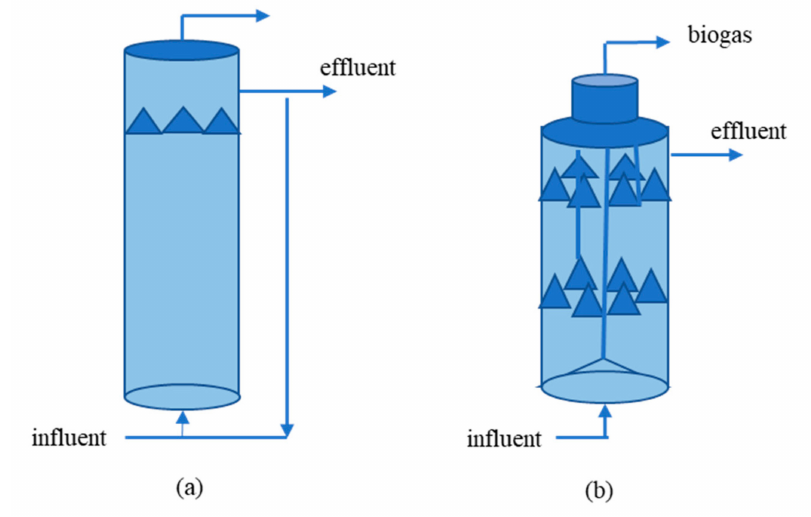
Figure 1. Structural diagram of EGSB and IC reactors (( a ) EGSB, ( b )